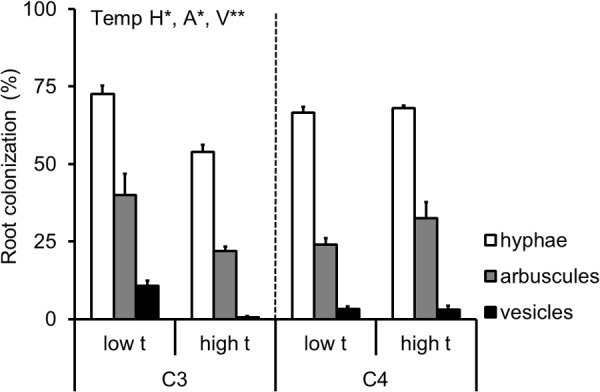
Extent of root length colonized by the mycorrhizal fungal structures of the AMF-inoculated C3- and C4-Panicum grasses growing side by side in the mixed culture containers. Colonization levels are shown by the hyphae (H), arbuscules (A) and vesicles (V) as assessed microscopically following staining with Trypan blue, separately for the two grass species as affected by cultivation temperature (low t, 25°C during daytime; high t, 36°C during daytime). Mean values ± standard errors are shown (n = 4 for high t treatment and n = 3 for the low t treatment). Significance of temperature treatment is indicated for the C3 plants only (∗0.05 > p ≥ 0.01, ∗∗0.01 > p ≥ 0.001) because there was no statistically significant effect of temperature recorded for any of the parameters in the C4 plants.